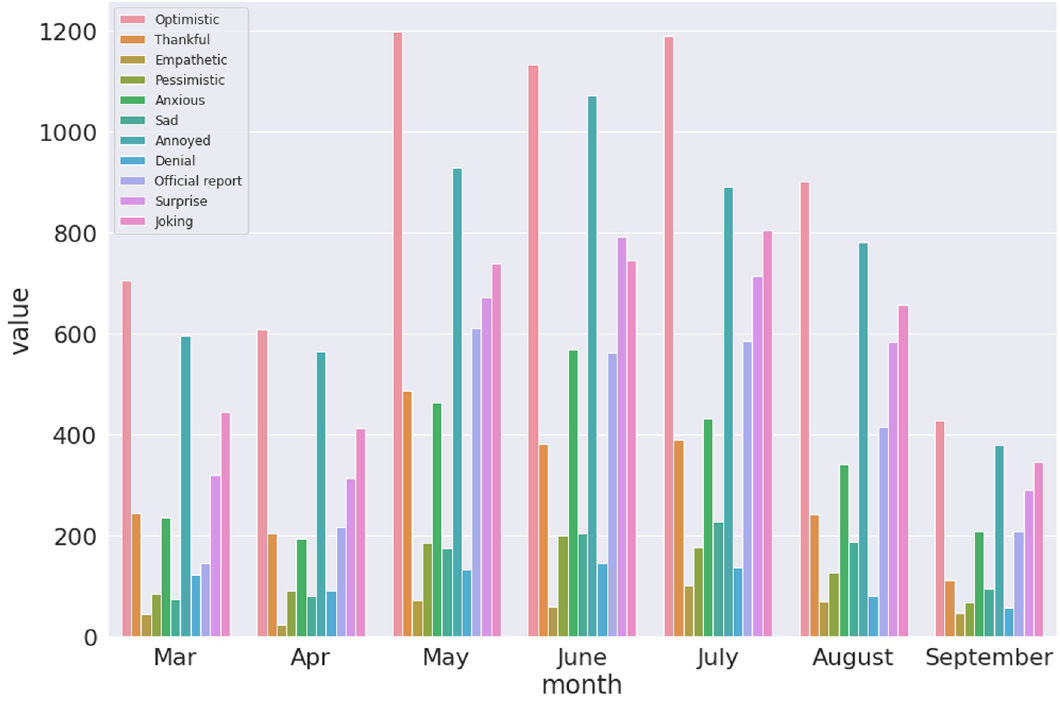
Fig 12. Monthly COVID-19 sentiments in Delhi using the BERT